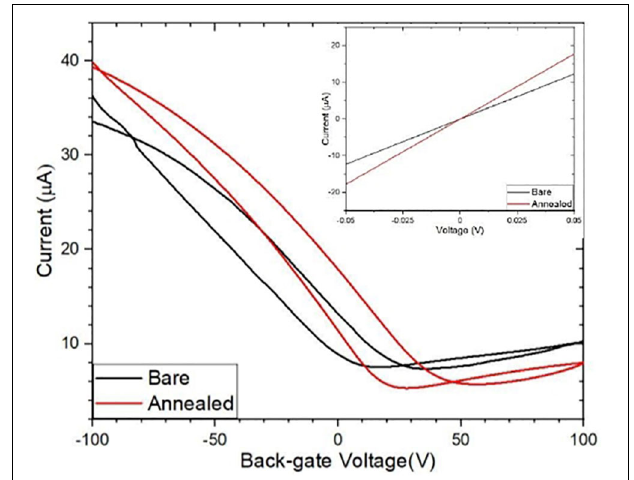
FIGURE 6 | Comparison of the bare and annealed I D –V G curves with their corresponding I D –V D curves (inset).